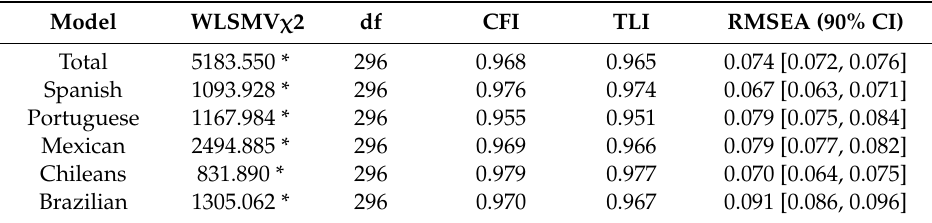
Table 3. Model fit indexes.